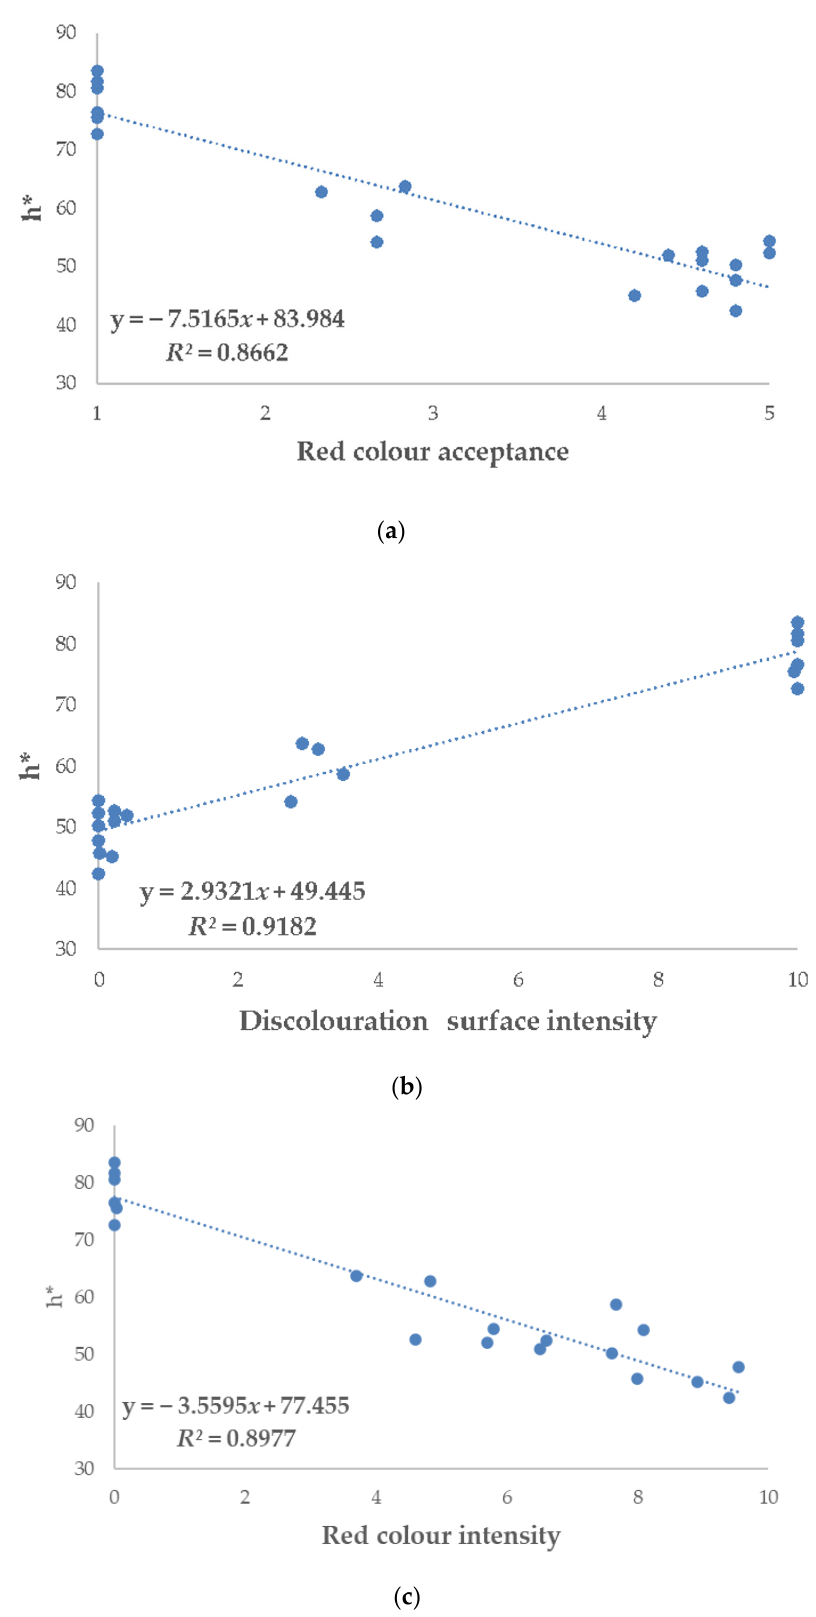
Figure 6. ( a ) Relationship between h* and red colour acceptance; ( b ) Relationship between h* and red colour intensity; ( c ) Relationship between h* and discolouration surface intensity.